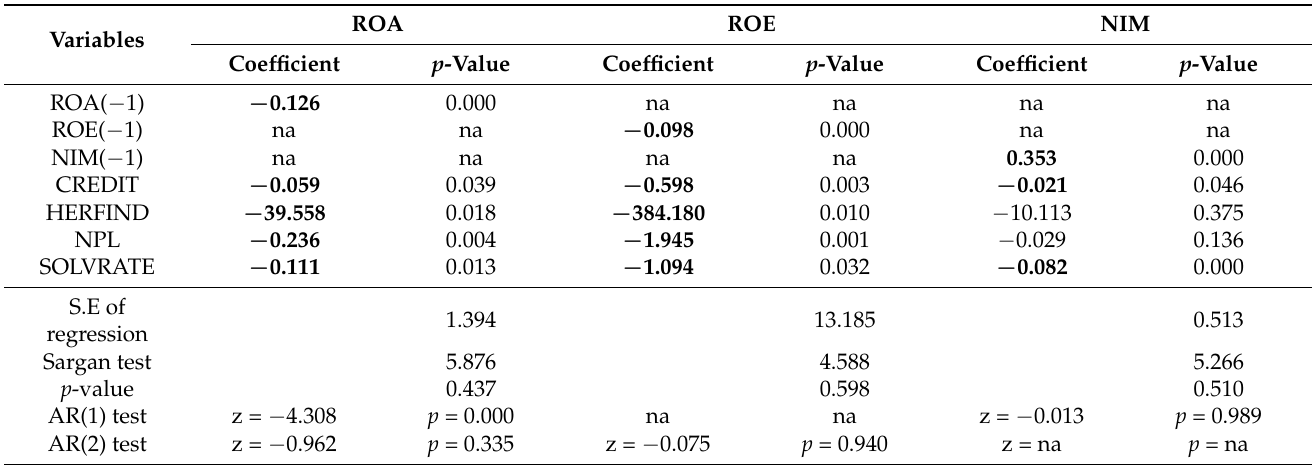
Table 4. Results of System GMM estimations for financial market variables